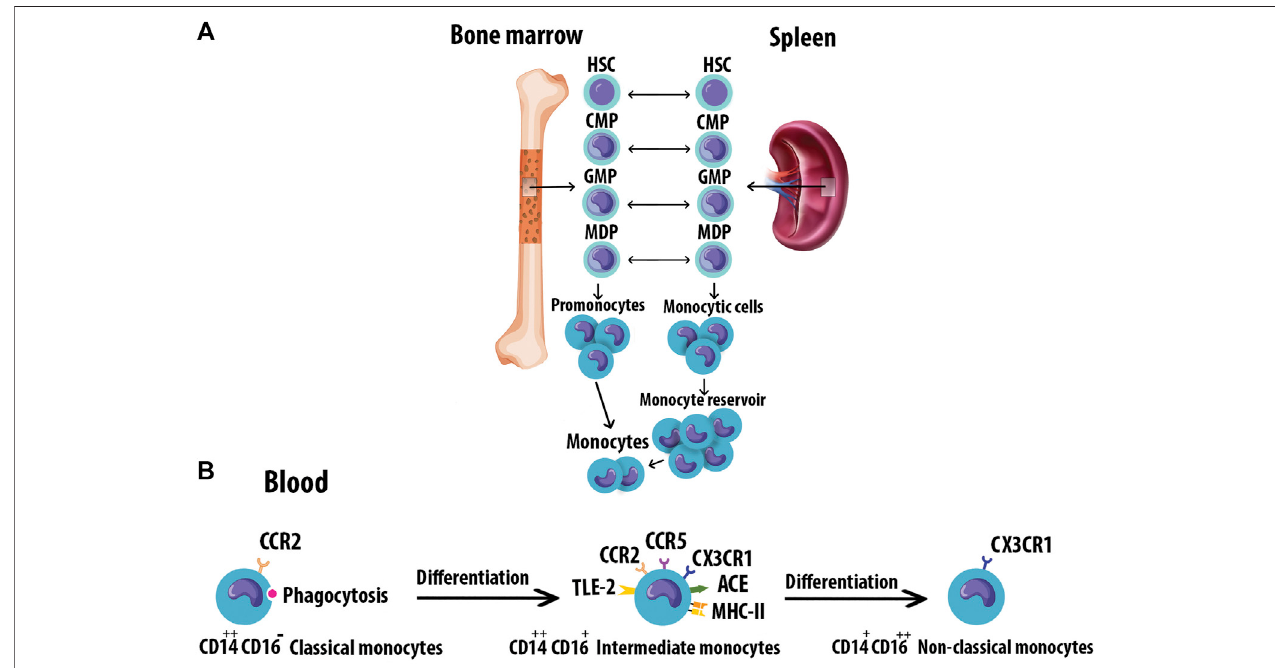
FIGURE 2 | Monocyte origin and heterogeneity. (A) Blood monocytes originate from HSC-derived progenitors with myeloid restricted differentiation potential. Successive commitment steps in the bone marrow include CMPs, GMPs, and MDPs. MDPs give rise to monocytes. (B) Human monocytes are classi fi ed into three subtypes based on the differential expression of CD14 and CD16. Monocytes mature in the bone marrow and are subsequently released into the circulation. Progressively,classical monocytes CD14 ++ CD16 giverise tonon-classical monocytes CD14 + CD16 ++ through anintermediatestepofCD14 ++ CD16 + monocytes. Hematopoietic stem cell (HSC), Common myeloid progenitors (CMPs), Granulocyte-M φ precursors (GMPs), M φ /Dendritic cell progenitor cells